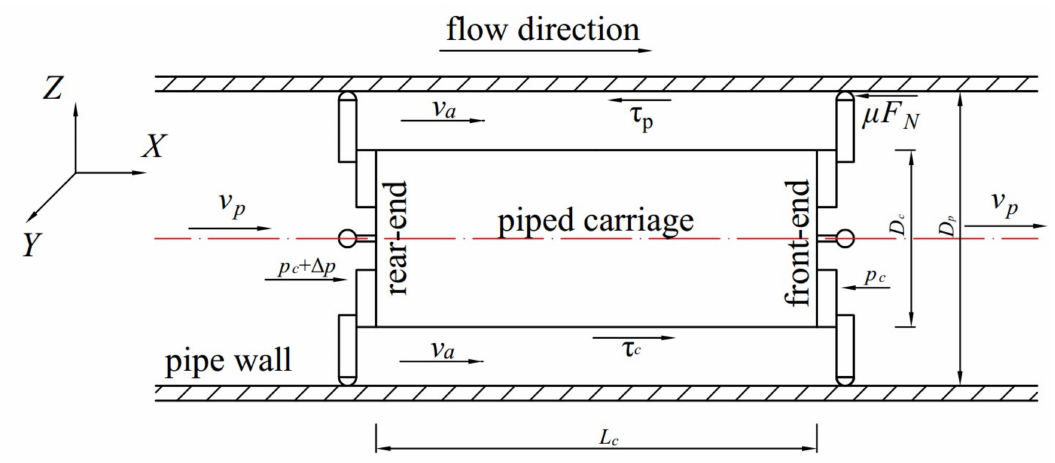
Figure 2. Forces acting on a stationary piped carriage in a straight